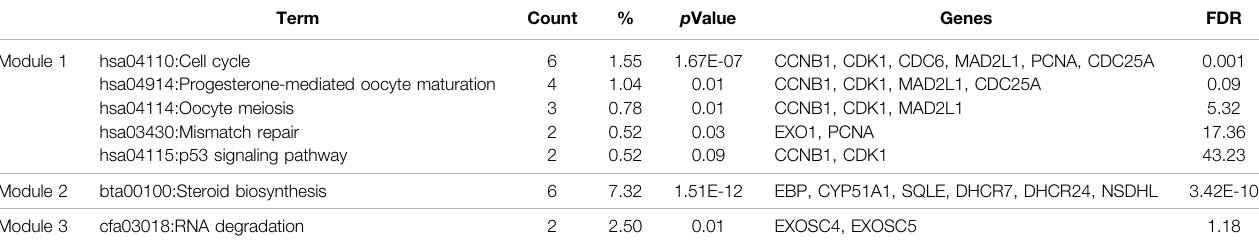
TABLE 4 | The enriched pathways of top three modules.